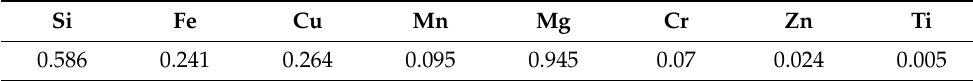
Table 1. Chemical composition of 6061 aluminum alloy (% in weight). Si Fe Cu Mn Mg Cr Zn